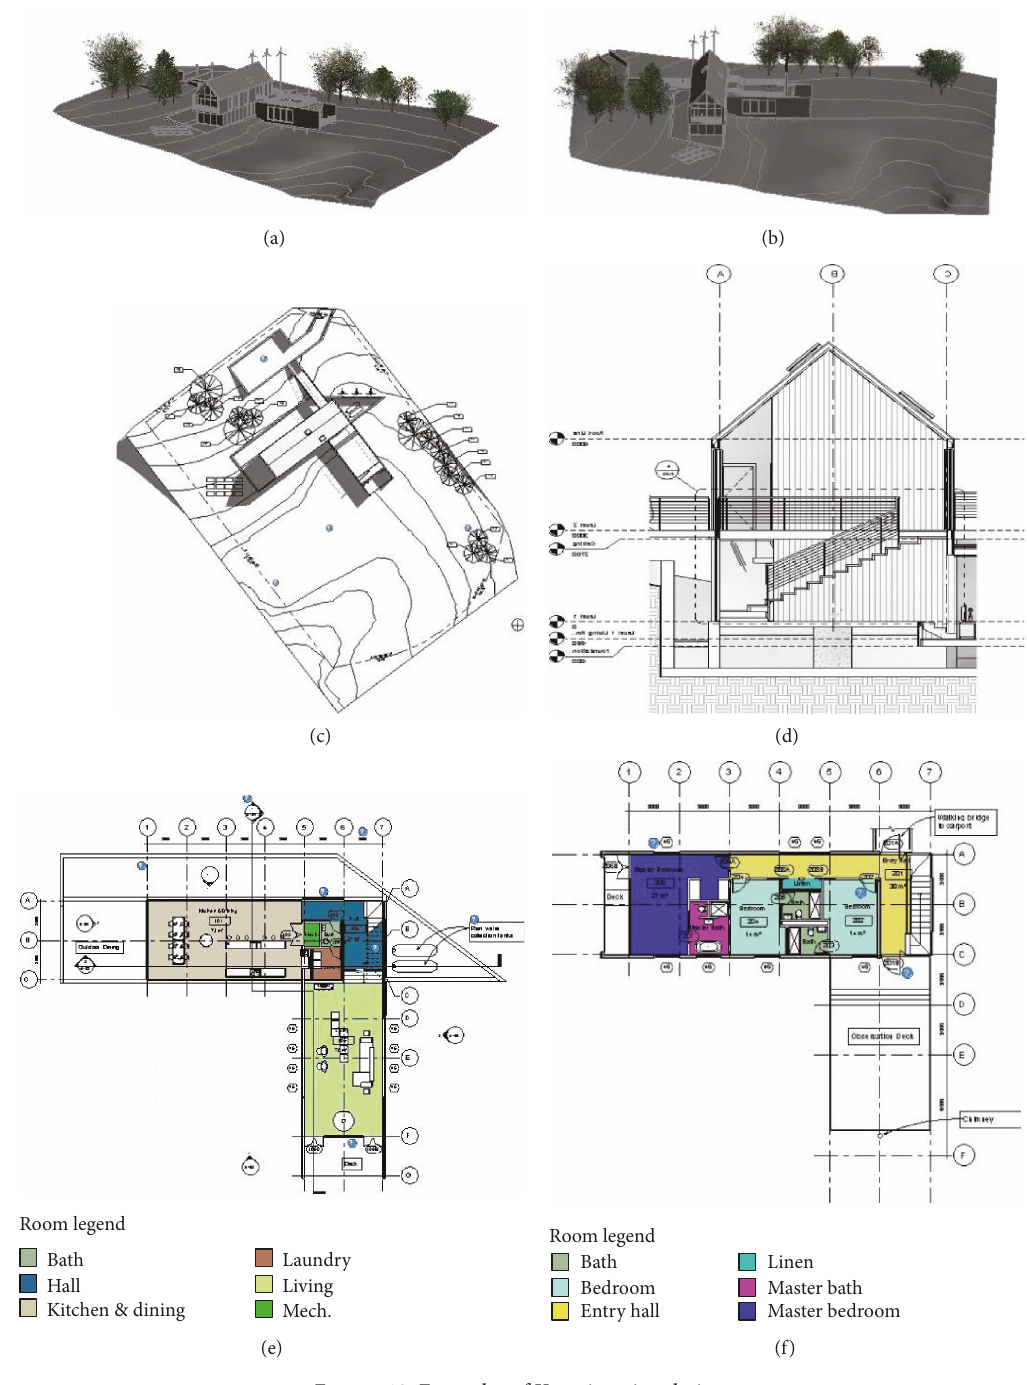
Figure 13: Examples of X engineering